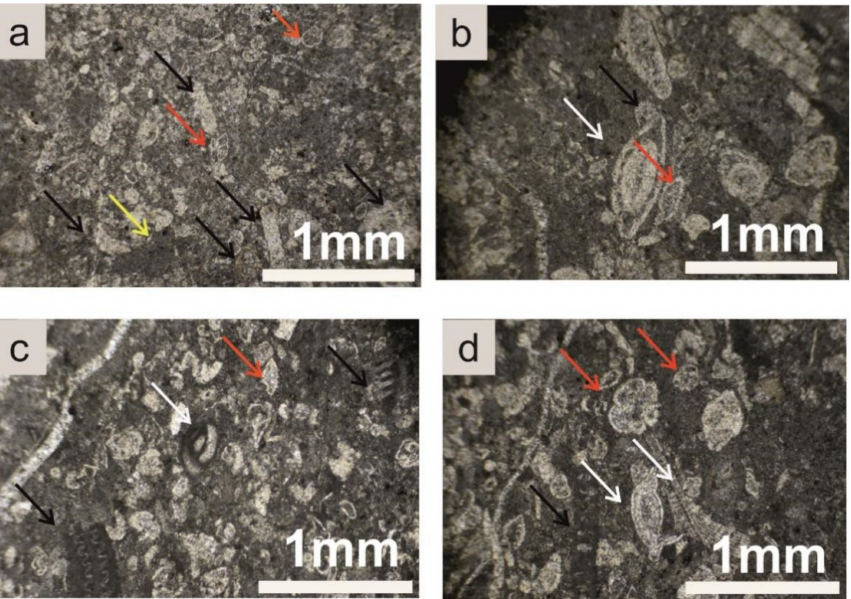
Figure 12. Microfacies type F2: Polymict clast supported microbreccia of Paleocene age. ( a ) planktic foraminifera (red arrow), bioclasts (black arrow), benthic foraminifera (white arrow), micritic clasts (yellow arrow), sample KM10, ( b ) planktic foraminifera (red arrow), bioclasts (black arrow), Miliolidae (white arrow), sample KM9, ( c ) planktic foraminifera (red arrow), bioclasts (black arrow), benthic foraminifera (white arrow), sample KM8, ( d ) planktic foraminifera (red arrow), bioclasts (black arrow), benthic foraminifera (white arrow), sample KM8.